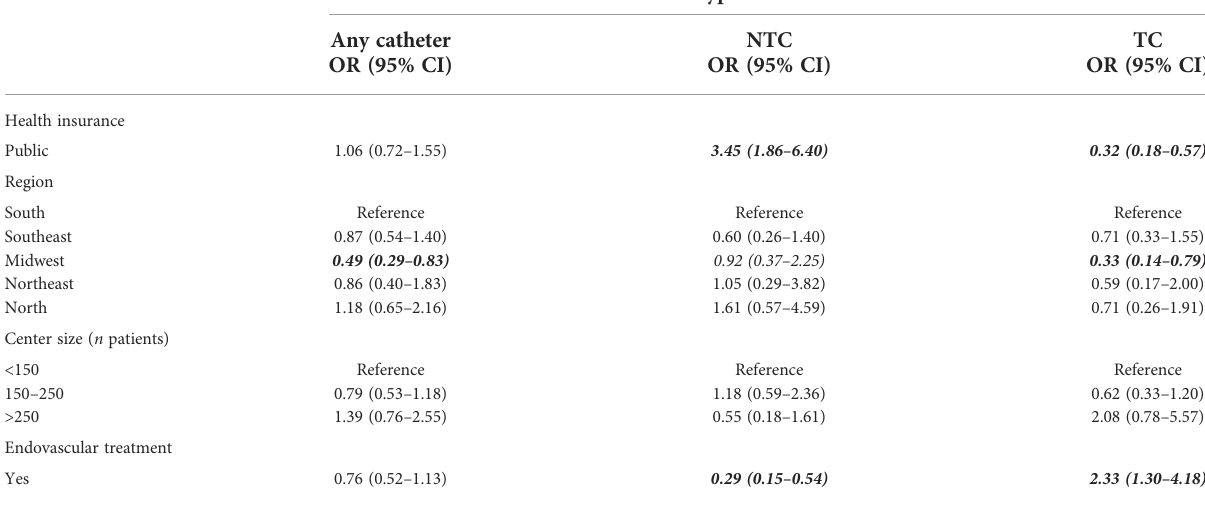
TABLE 6 Model 1 for adjusted multilevel logistic regression for the risk of having a hemodialysis (HD) catheter.